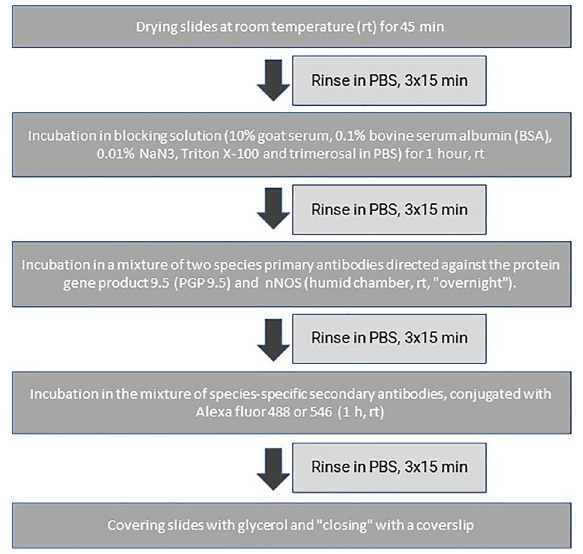
Figure 3. The scheme of labelling used during the present study. PBS phosphate buffered saline, nNOS neuronal isoform of nitric oxide